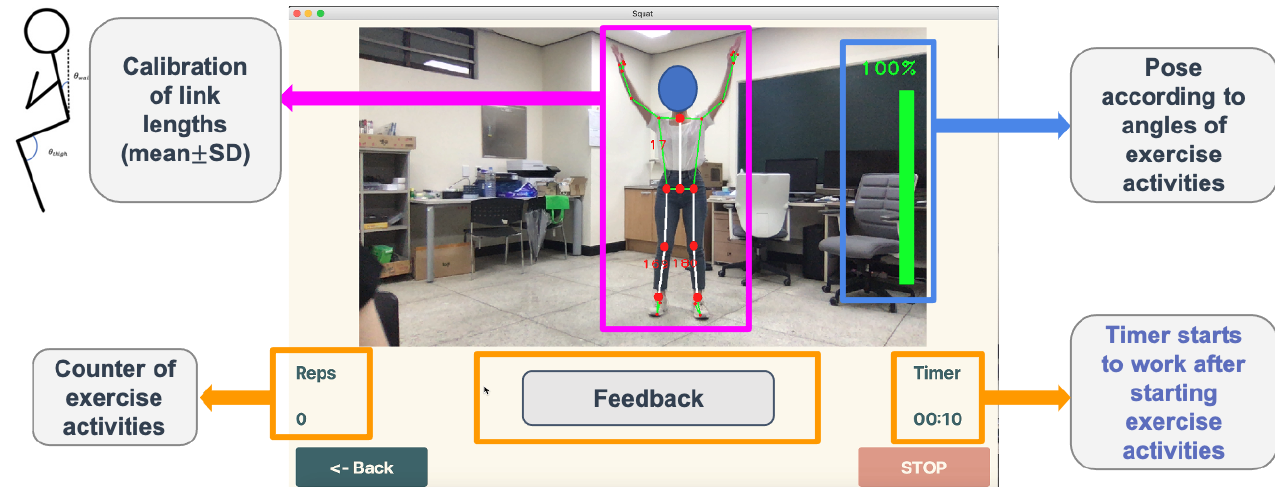
Figure 11. A description of graphical user interface (GUI) for the developed fitness